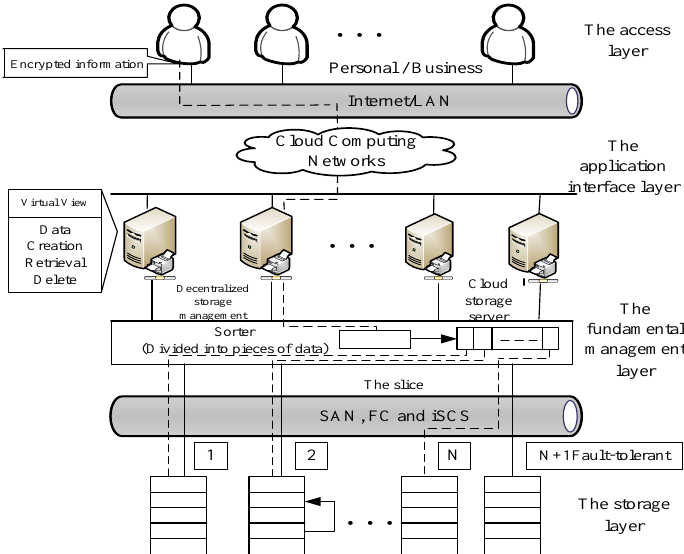
Figure 5. The security architecture of the integration information